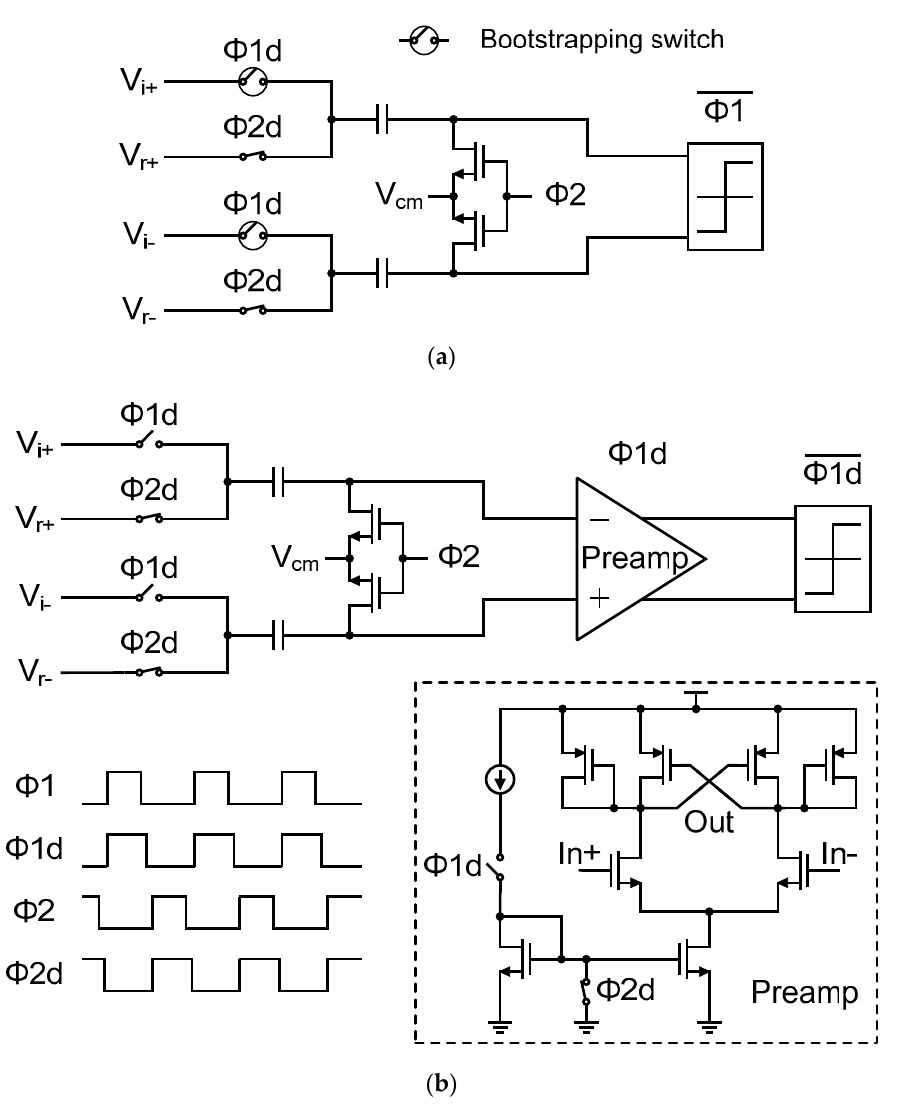
Figure 5. ( a ) Comparator in the first stage; ( b ) Comparator in the following stages.